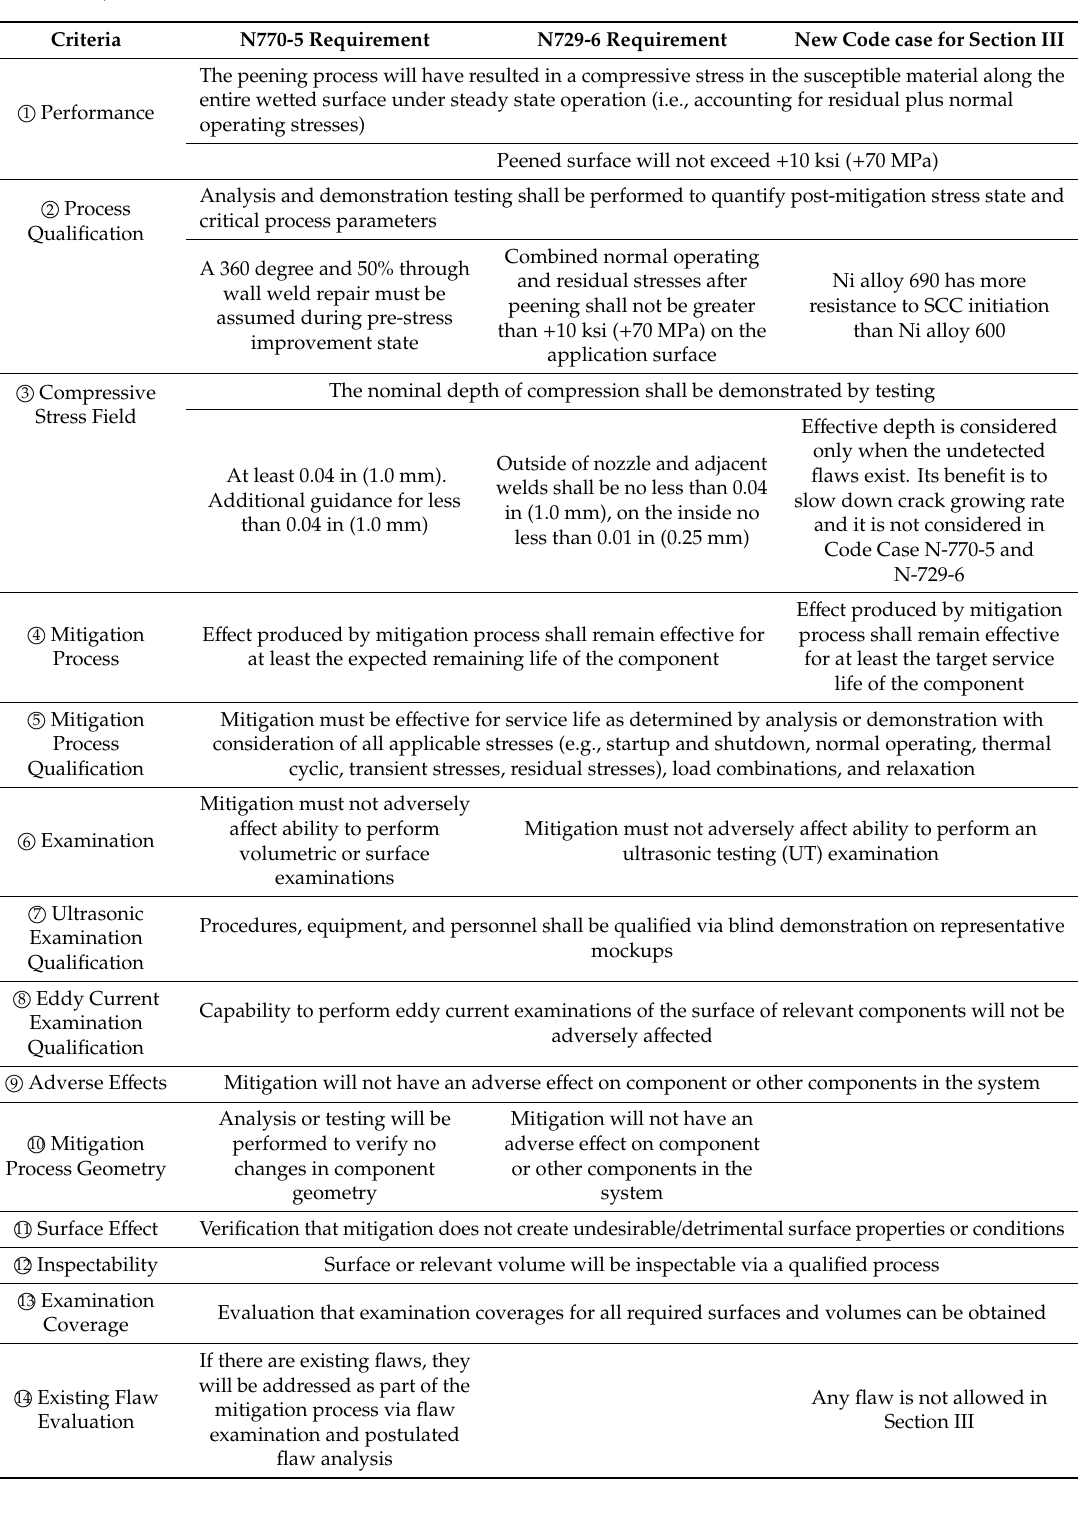
Table 3. Comparison of performance criteria and mitigation process criteria: Section XI (N770-5 and N729-6) and New Code Case for Section